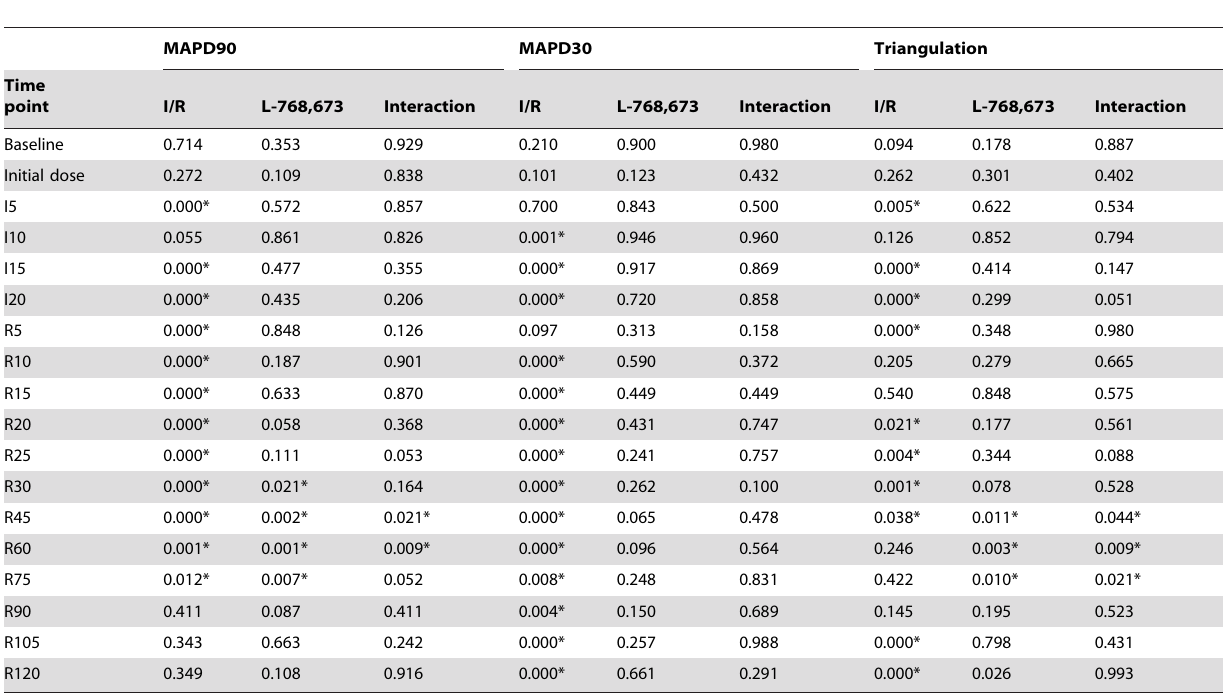
Table 1. The P value of main effects and interaction effects of I/R or sham operation and L-768,673 or vehicle on MAPD and triangulation.